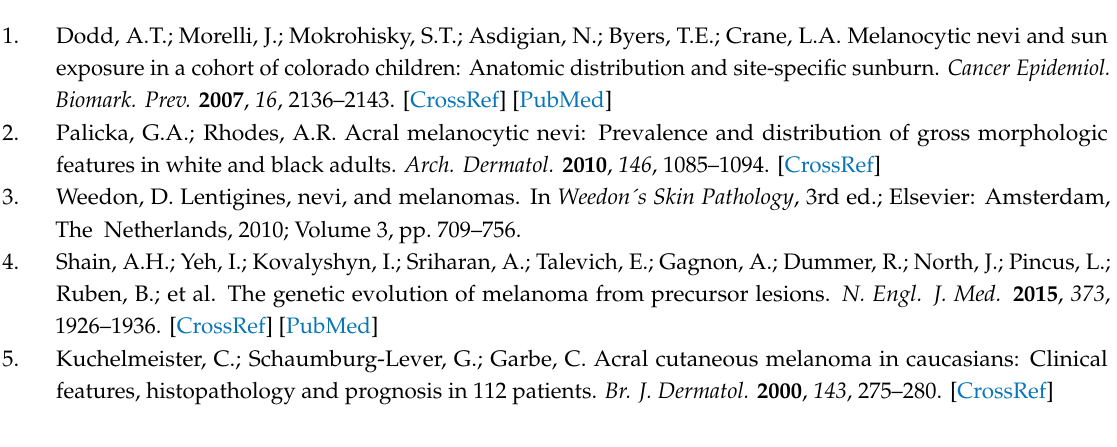
s1; Figure S1: Associations of histological type with size and volume of naevi, Table S1: Associations of histopathological type of naevus with size (in mm 2 ), Table S2: Genes covered in the applied sequencing panel, Table S3: Genes covered in the additional 29 gene sequencing panel (entire gene exons were